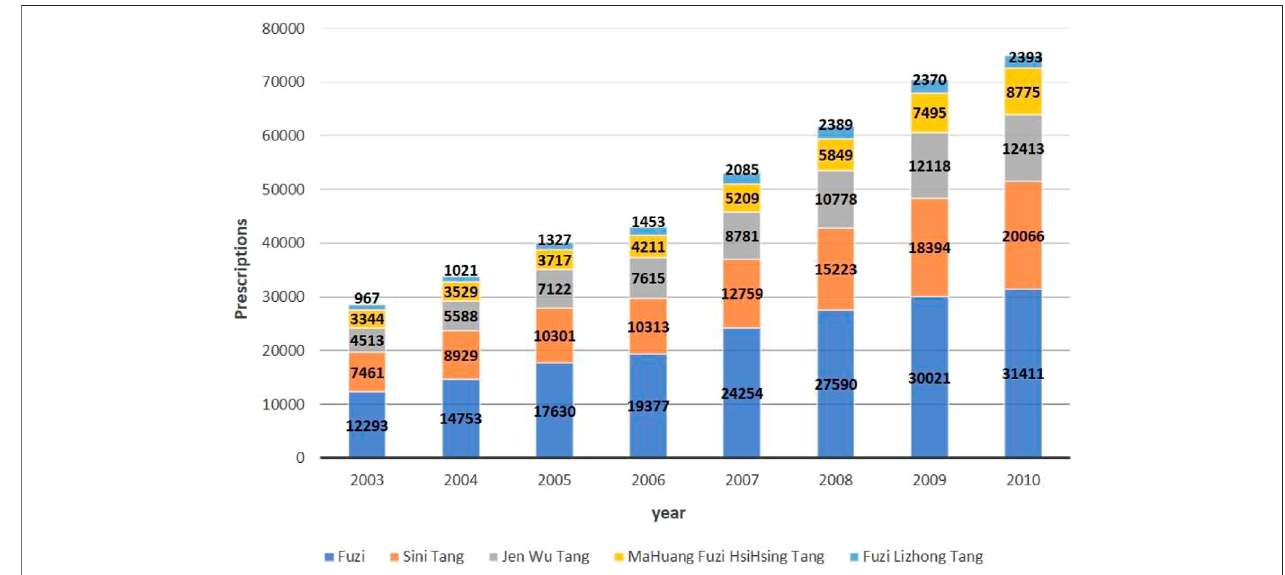
FIGURE 1 | National trends in the prescriptions of Fuzi and Fuzi-based formulas during 2003 – 2010.